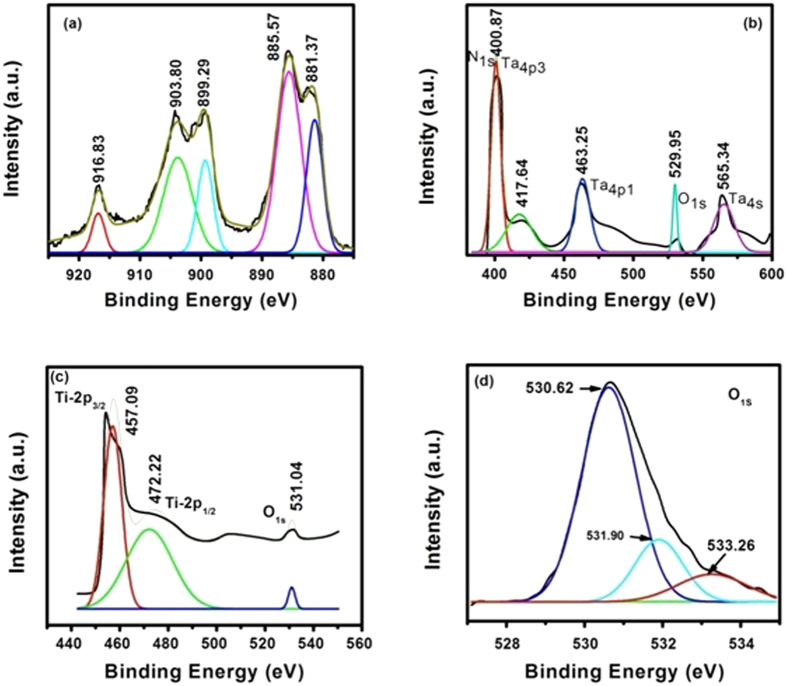
XPS binding energy profiles.(a) CeO2 layers, (b) TaON profile for TaN/CeO2/Ti/ CeO2/Pt devices, (c) Trace profile of Ti in Ti/CeO2/Ti/CeO2/Pt devices and (d) O 1 s profile in Ti/CeO2/Ti/CeO2/Pt devices.